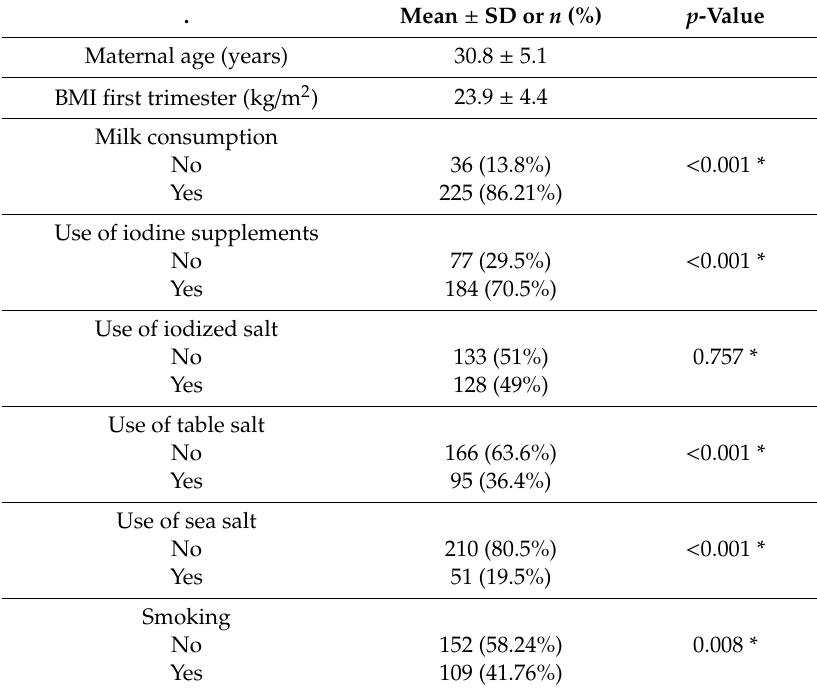
Table 2. Sociodemographic characteristics of the sample.